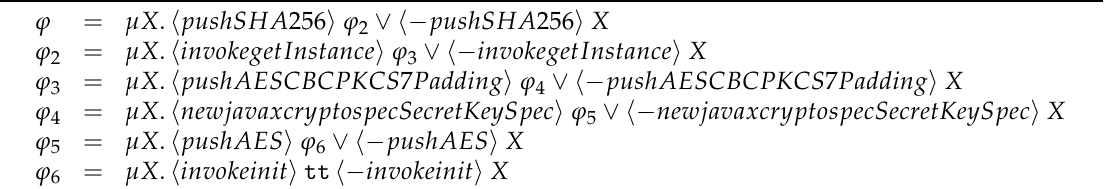
Table 3. Temporal Logic property for Simplelocker potentially malicious behaviour